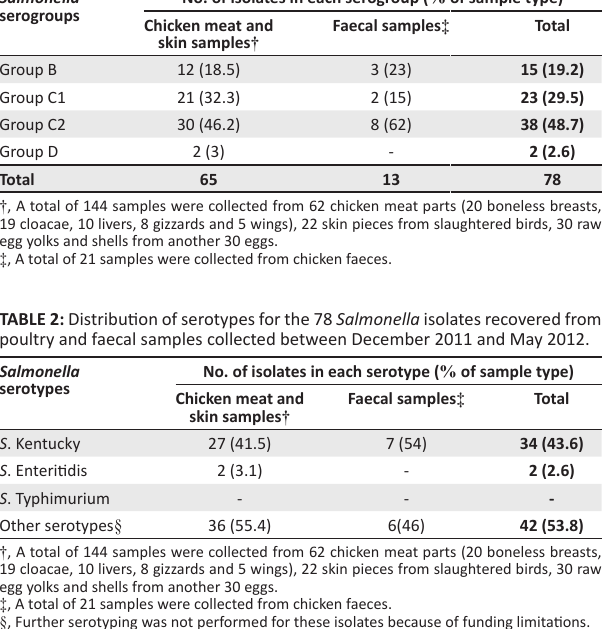
TABLE 1: Distribution of Salmonella serogroups isolated from 144 poultry samples and 21 faecal samples collected between December 2011 and May 2012. Salmonella serogroups